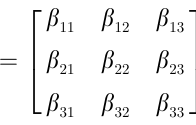
Table 2. Disease dynamics parametrisation of disease course and characteristics of COVID-19. Description Value Percentage asymptomatic cases in the population [1,22] 15% Percentage asymptomatic transmission relative to symptomatic transmission [1] 30% Exposed duration (E1 + E2) (days, log-normal distribution) [24–26] 5 (SD 3), max Exposed duration 2 (E2) (days) [27] 2 Infectivity duration (I) (days) [28] 5 (SD 3), max Delay from symptom onset to medical assessment and COVID-19 testing (days, log-normal distribution) [24] Average length of stay in medical ward beds (days) [28] 11 Average length of stay in ICU (days) [28] 8 Average additional length of ICU stay with subsequent inpatient mortality (days) [28,29] 2 Mean percentage of symptomatic infected requiring hospitalisation for age 0–4 (SD = 1.2, log- normal distribution) [28,29] Mean percentage of symptomatic infected requiring hospitalisation for age 5–19 (SD = 1.2, log- normal distribution) [28,29] Mean percentage of symptomatic infected requiring hospitalisation for age 20–64 (SD = 1.2, log- normal distribution) [28,29] Mean percentage of symptomatic infected requiring hospitalisation for age over 65 (SD = 1.2, log- normal distribution) [28,29] Mean percentage of admitted cases requiring ICU for age 0–4 (SD = 1.2, log-normal distribution) [28,29] Mean percentage of admitted cases requiring ICU for age 5–19 (SD = 1.2, log-normal distribution) [28,29] Mean percentage of admitted cases requiring ICU for age 20–64 (SD = 1.2, log-normal distribution) [28,29] Mean percentage of admitted cases requiring ICU for age over 65 (SD = 1.2, log-normal distribution) [28,29] Mean percentage mortality in those admitted to ICU for age 0–4 (SD = 1.2, log-normal distribution) [28,29] Mean percentage mortality in those admitted to ICU for age 5–19 (SD = 1.2, log-normal distribution) [28,29] Mean percentage mortality in those admitted to ICU for age 20–64 (SD = 1.2, log-normal distribution) [28,29] Mean percentage mortality in those admitted to ICU for age over 65 (SD = 1.2, log-normal distribution) [28,29] For the purposes of our simulation we used a 15% asymptomatic infection rate and the relative infectiousness of asymptomatic carriers was 30% compared to symptomatic cases